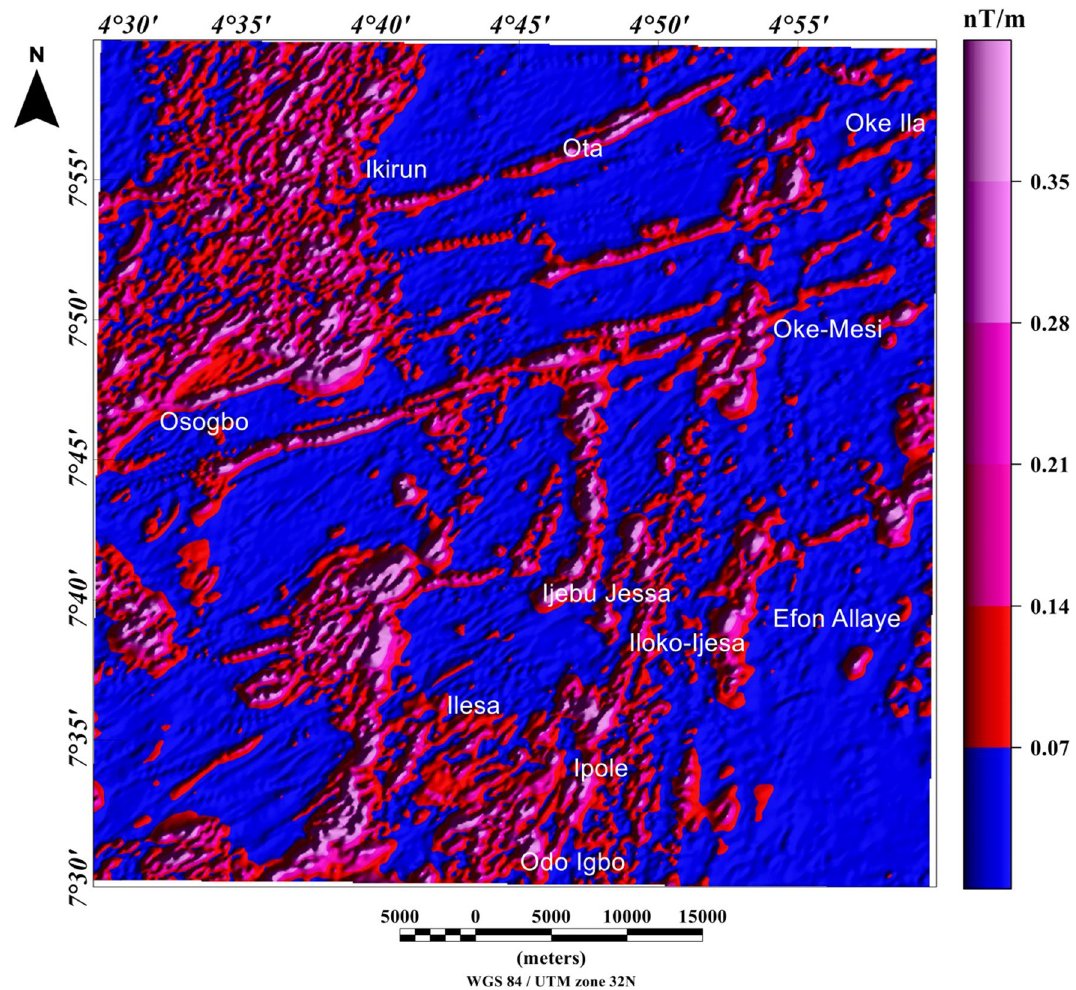
Figure 7. Total gradient amplitude map produced from the total field anomaly data of the study area presented in color-shaded relief, illuminated from the east-southeast direction. The east-southeast illumination (azimuth: 112.5 degrees and light angle: 45 degrees) enhances east-northeast lineaments. The figure was produced using Oasis Montaj Software version 8.3.3 (Website: https:// www. seequ ent. Satellite data. The Shuttle Radar Topographic Mission (SRTM) digital elevation data of the Ife-Ilesha schist belt was downloaded from the website of the United State Geological Survey (USGS). The spatial resolution of the SRTM data is 3 arc seconds (approximately 90 m). The SRTM digital elevation data of the study area was hill-shaded using 45° light angle at azimuths of 112.5° and 337.5° (Figs. 4, 5) to highlight east-northeast and north-northeast structural trends, respectively; which are the main regional structural trends. The produced shaded-relief maps (Figs. 4, 5) will help reveal the influence of the subsurface structural features structures on the topography of the studied region. The Line algorithm of PCI Geomatica software was used to extract dif- ferent lengths and directions of morphological features on the shaded-relief maps, on the basis of variation in surface features using the values of the six parameters (Table 1). Finally, rose diagram was produced from line- aments extracted from the shaded-relief maps to assess trends of surface structural features within the region. Aeromagnetic and radiometric data. The total field anomaly and airborne radiometric data investigated were derived from the regional aeromagnetic and radiometric datasets of Nigeria. The datasets were acquired by a geophysical company (Fugro Airborne Surveys) on behalf of the Nigerian Geological Survey Agency between 2004 and 2009. The datasets were collected at an interval of 1.0 s (approximately 75 m) for radiometric and 0.1 s (approximately 7.0 m) for aeromagnetic measurements. The aeromagnetic survey was recorded at a sensor mean terrain clearance of 80 m on a series of NW–SE oriented flight lines (perpendicular to regional trends). The flight lines were spaced 500 and tied at 2000 m. The aeromagnetic data was corrected for diurnal variations with the main component of the geomagnetic field (IGRF) also removed. The processing routine of the resulting total field anomaly (TFA) and radiometric data comprised of the fol- lowing phases: (a) Application of total gradient amplitude (TGA) technique to the TFA data to produce the TGA map of the region which reveals structural features; (b) extraction of maxima of the TGA to produce magnetic